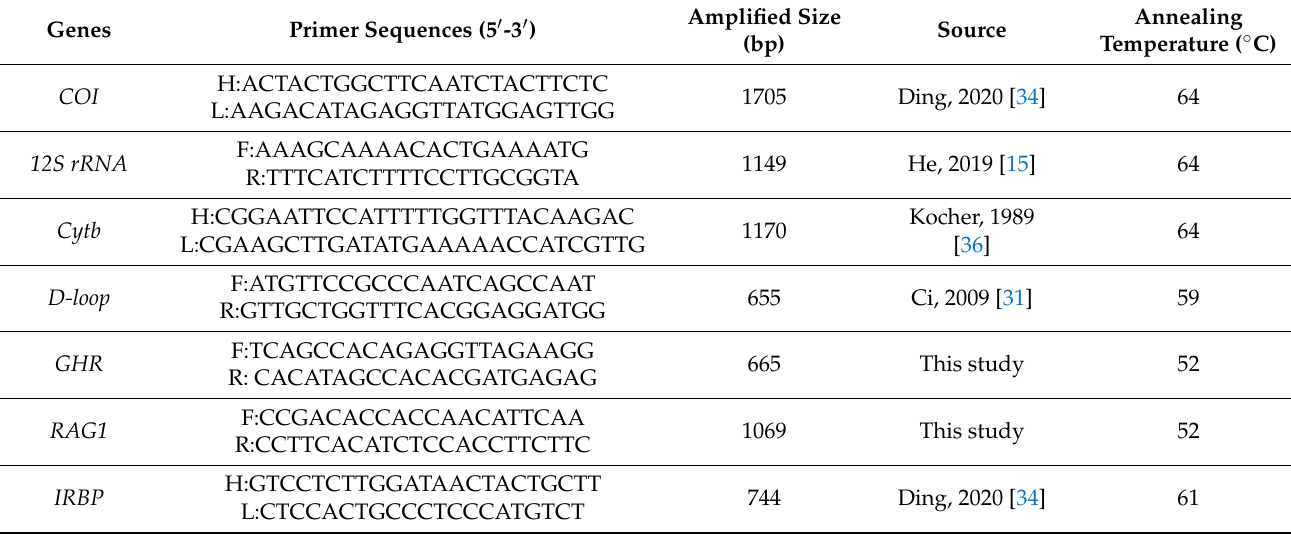
Table 2. Primers used in this